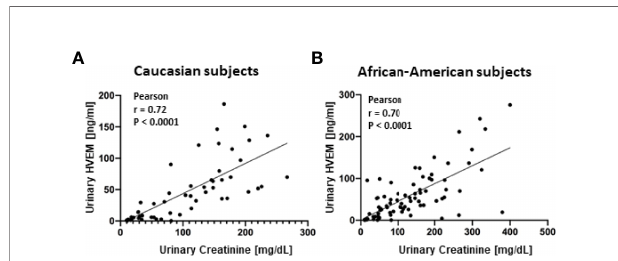
FIGURE 5 | Extended ELISA validation of urine HVEM in an independent cohort of subjects. Urine HVEM, the most promising biomarker for urine biomarker normalization, was assayed in an additional cohort of Caucasian (A) and African American (B) subjects, again showing a signi fi cant positive correlation with urine creatinine across both races. In (A) , 23 SLE and 30 healthy urine samples were interrogated. In (B) , 49 SLE and 30 healthy urine samples